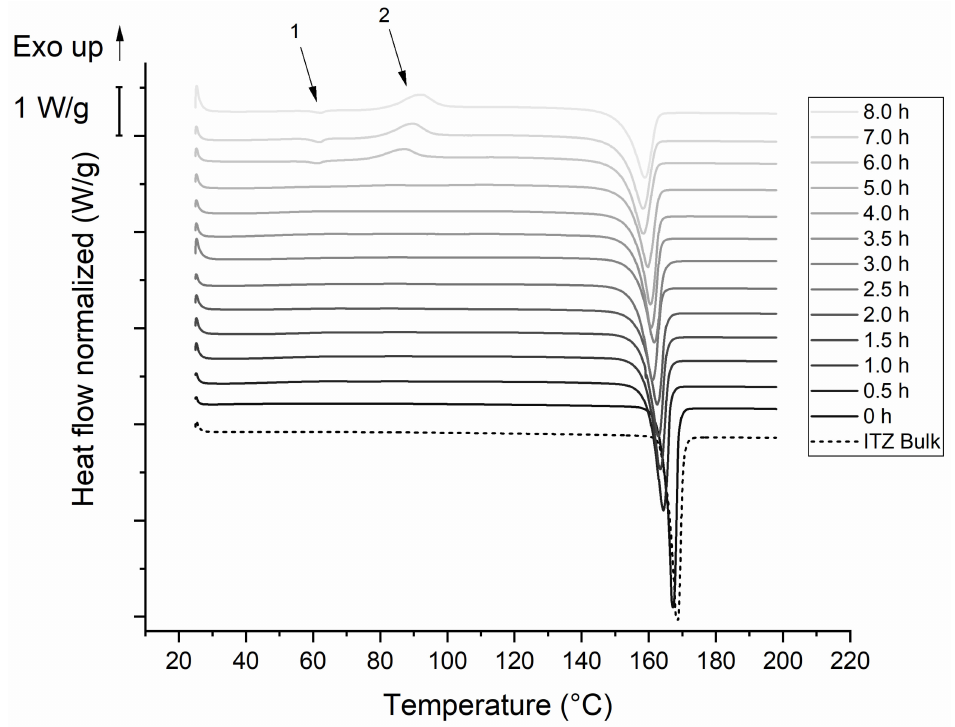
Figure 6. DSC-thermograms of F2 ITZ nanosuspension. Milling was carried out at 4 ◦ C with 1500 rpm and milling beads sized 0.3–0.4 mm. Plots are shifted for a better illustration. Arrow 1 marks an endothermic event, arrow 2 marks an exothermic